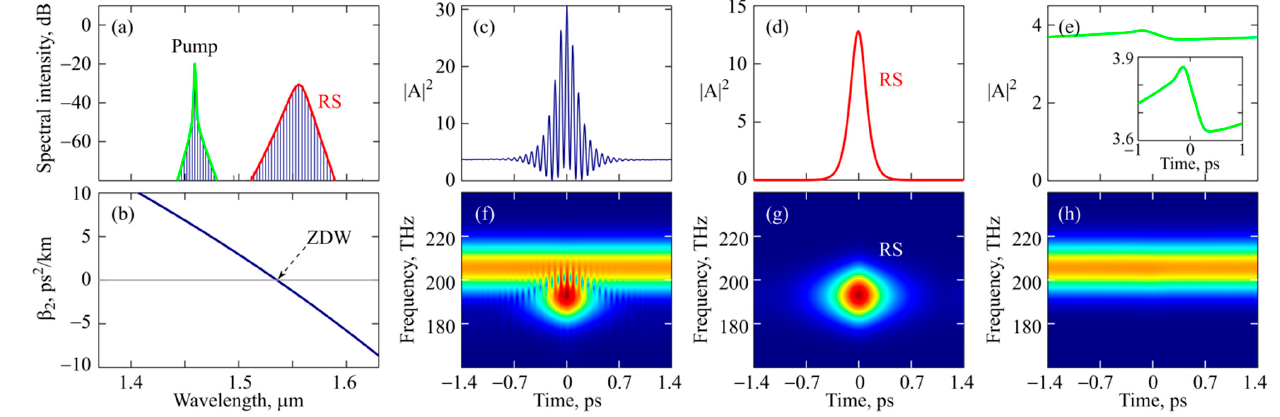
Figure 7. Numerical simulation . ( a ) Spectral intensity of optical frequency comb for Δ = 3.7 and P = 30. The red line shows spectral envelope for Raman soliton (RS) and the green line shows spectral envelope for weak comb near pump wavelength. ( b ) Dispersion of used microsphere; ZDW is zero dispersion wavelength. Temporal intensities of the entire frequency comb ( c ), RS ( d ), and weak comb near pump wavelength ( e ). Spectrograms of entire optical frequency comb ( f ), RS ( g ) and weak comb near pump wavelength ( h ). Window function for all spectrograms is exp[ − t 2 /(40 fs) 2